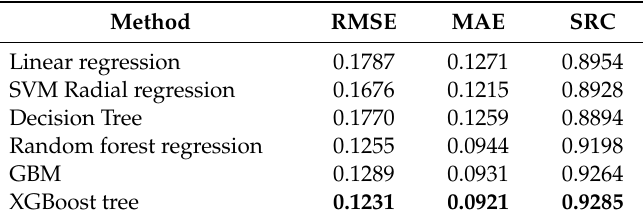
Table 3. Performance of di ff erent machine learning methods for Likes Prediction. Bold shows the best performance results.